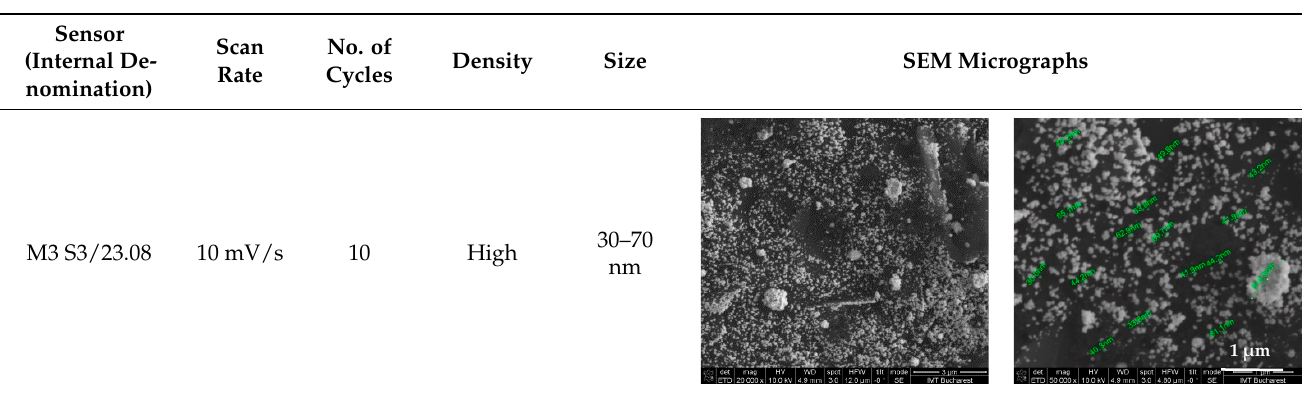
The size distribution of AuNPs was extracted from SEM micrographs by measuring 200 individual nanoparticles. The AuNPs’ diameter sizes, determined based on SEM analysis, were found to range from 23 nm to 94 nm for S6/02.08 (Figure 4, left) and from 30 nm to 120 for S7/02.08 (Figure 4, right). 30 nm to 120 for S7/02.08 (Figure 4, right).